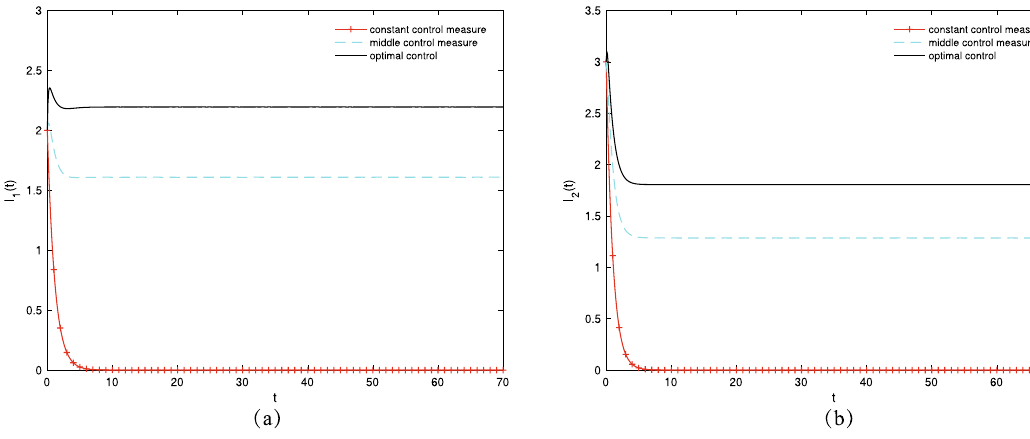
Figure 4. The densities of ( a ) I 1 ( t ) , ( b ) I 2 ( t ) change over time under different control strategies.